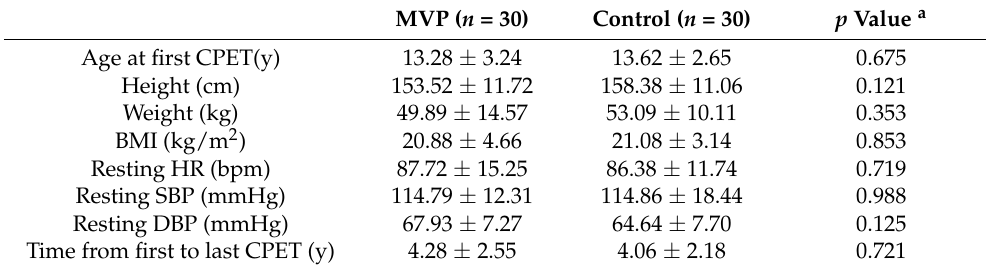
Table 1. Demographic characteristics of patients with mitral valve prolapse and control